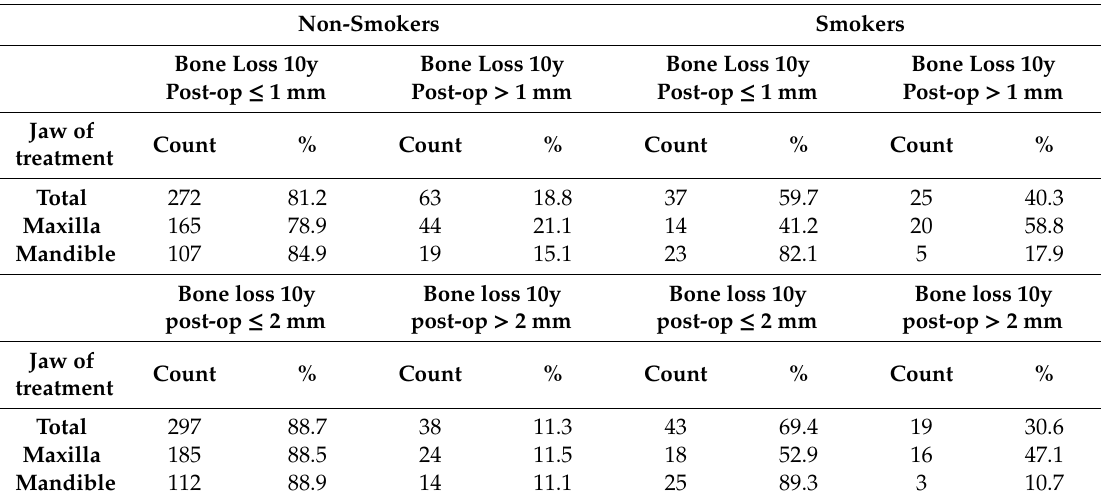
Table 5. Overview of the successful implants (with 1 mm and 2 mm marginal bone loss as success criterion) in smokers and non-smokers with respect to jaw